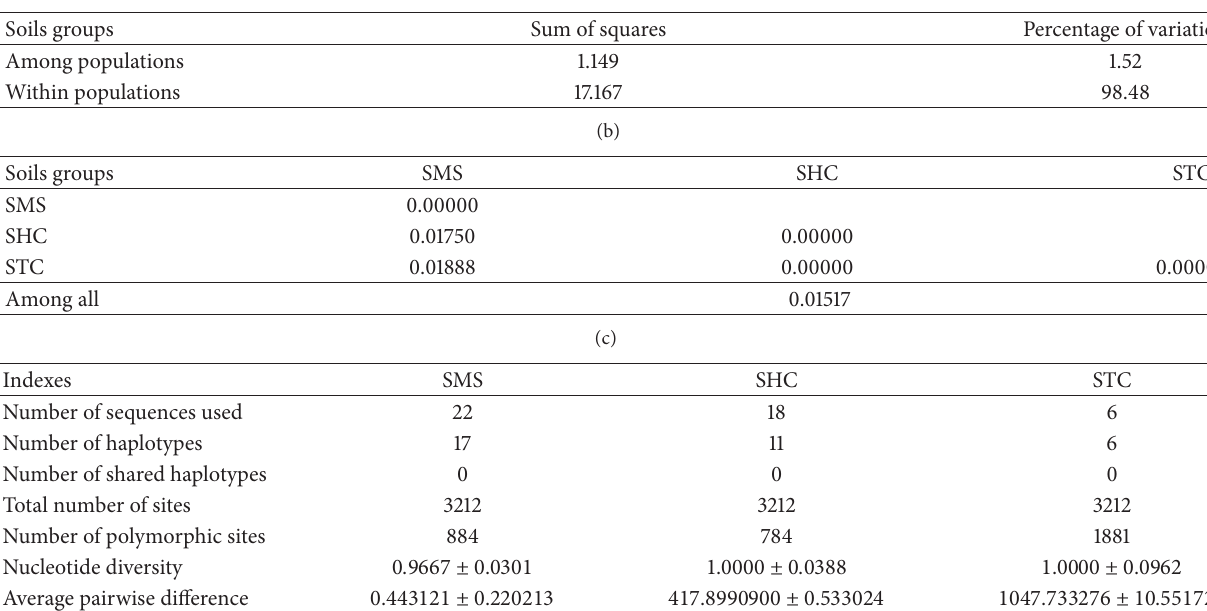
Table 2: Genetic distance between the soil and the values